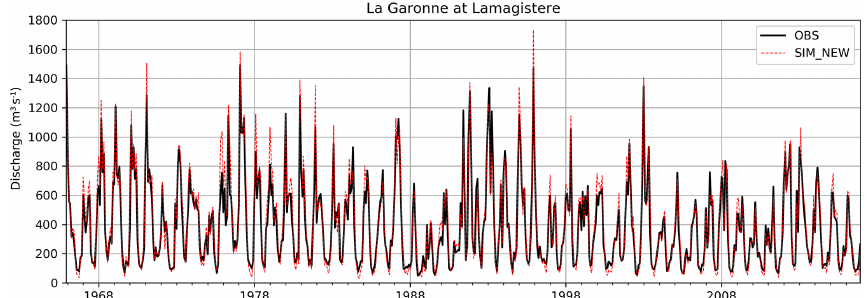
Figure 10. Comparison of monthly river flows with SIM_NEW for the Garonne at Lamagistère over the period